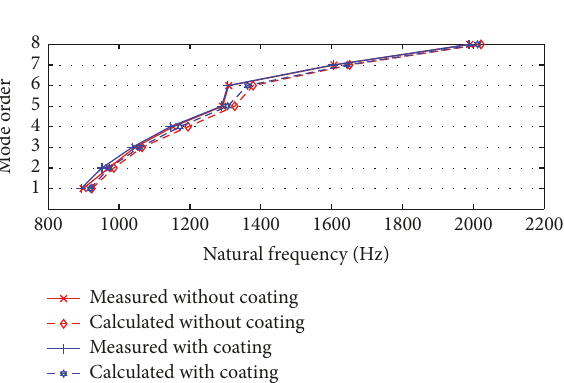
Figure 15: The relation curves of the measured and calculated natural frequencies of cantilever cylindrical shell with and without hard